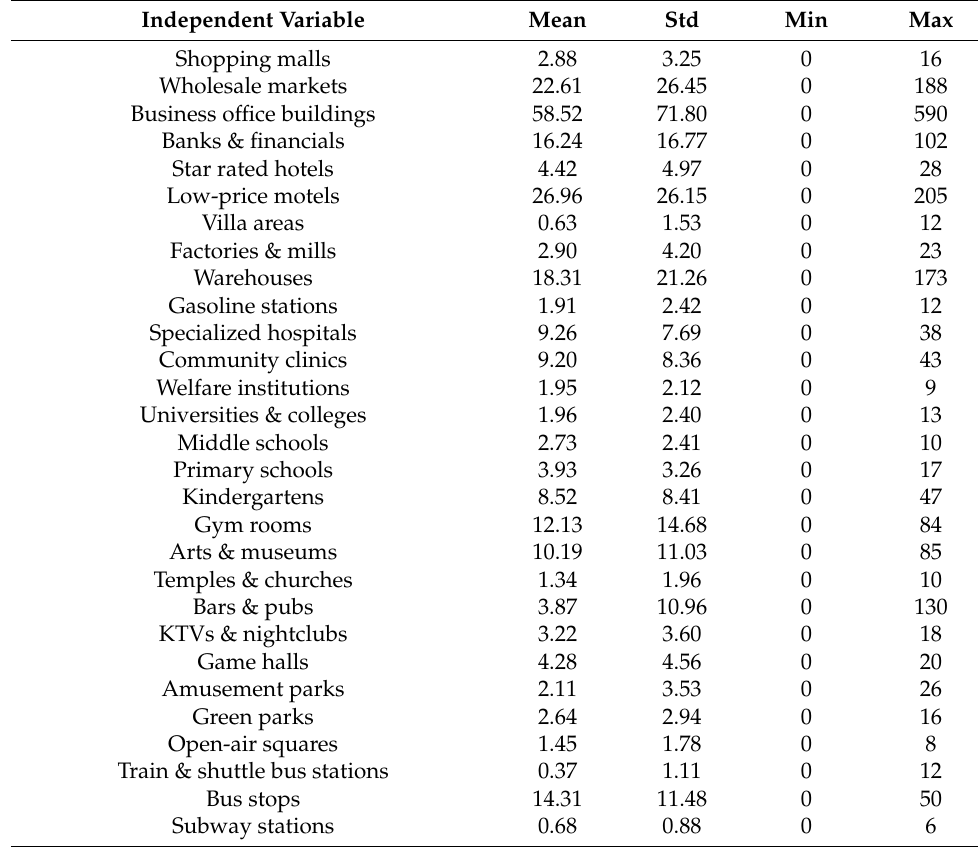
Table 3. Statistics of urban facility by AJPS